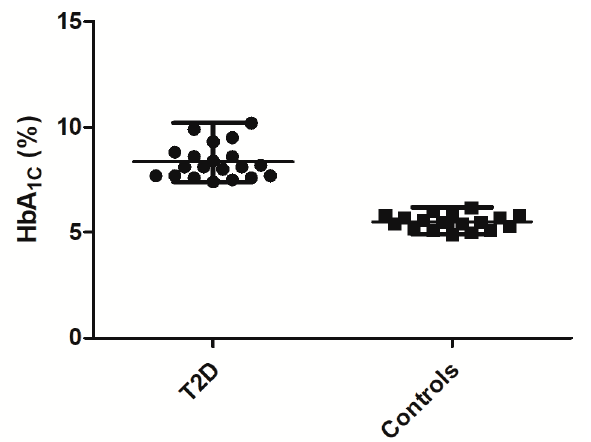
Figure 7. The level of HbA 1c in plasma samples obtained from patients with T2DM and healthy persons. Statistical significance was estimated by the Mann-Whitney U -test, p < 0.0001.